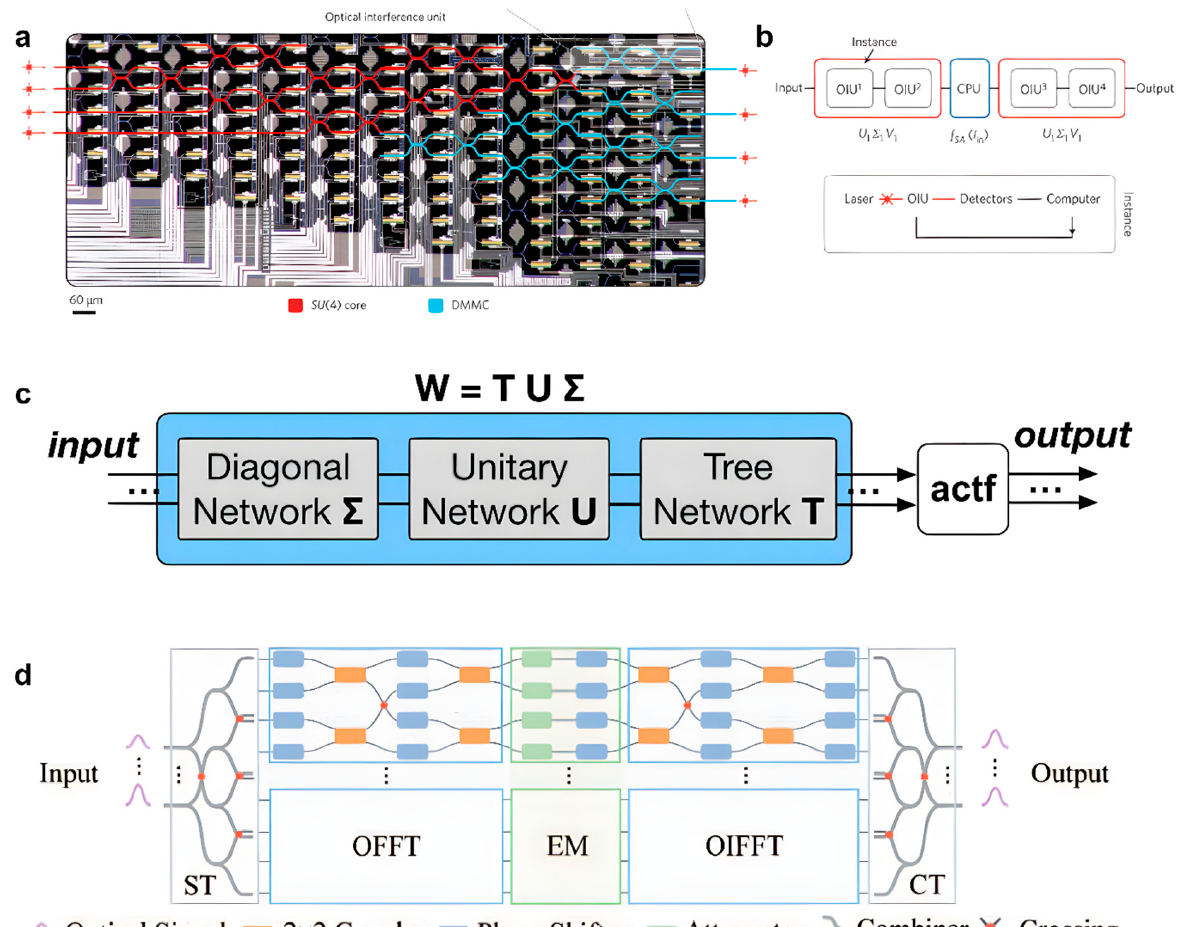
Figure 10. Implementation by interference of light. ( a ) Optical micrograph illustration of the experimentally demonstrated OIU [28]. ( b ) Schematic representation of our two-layer ONN experiment [28]. ( c ) Proposed slimmed layer implementation [93]. ( d ) Schematic diagram of a single layer of the proposed architecture [94]. ( a , b ) Reprinted with permission from Ref. [28]. Copyright © 2017, Nature Publishing Group. ( c ) Reprinted with permission from Ref. [93], ACM. ( d ) Reprinted with permission from Ref. [94]. Copyright © 2020 IEEE.